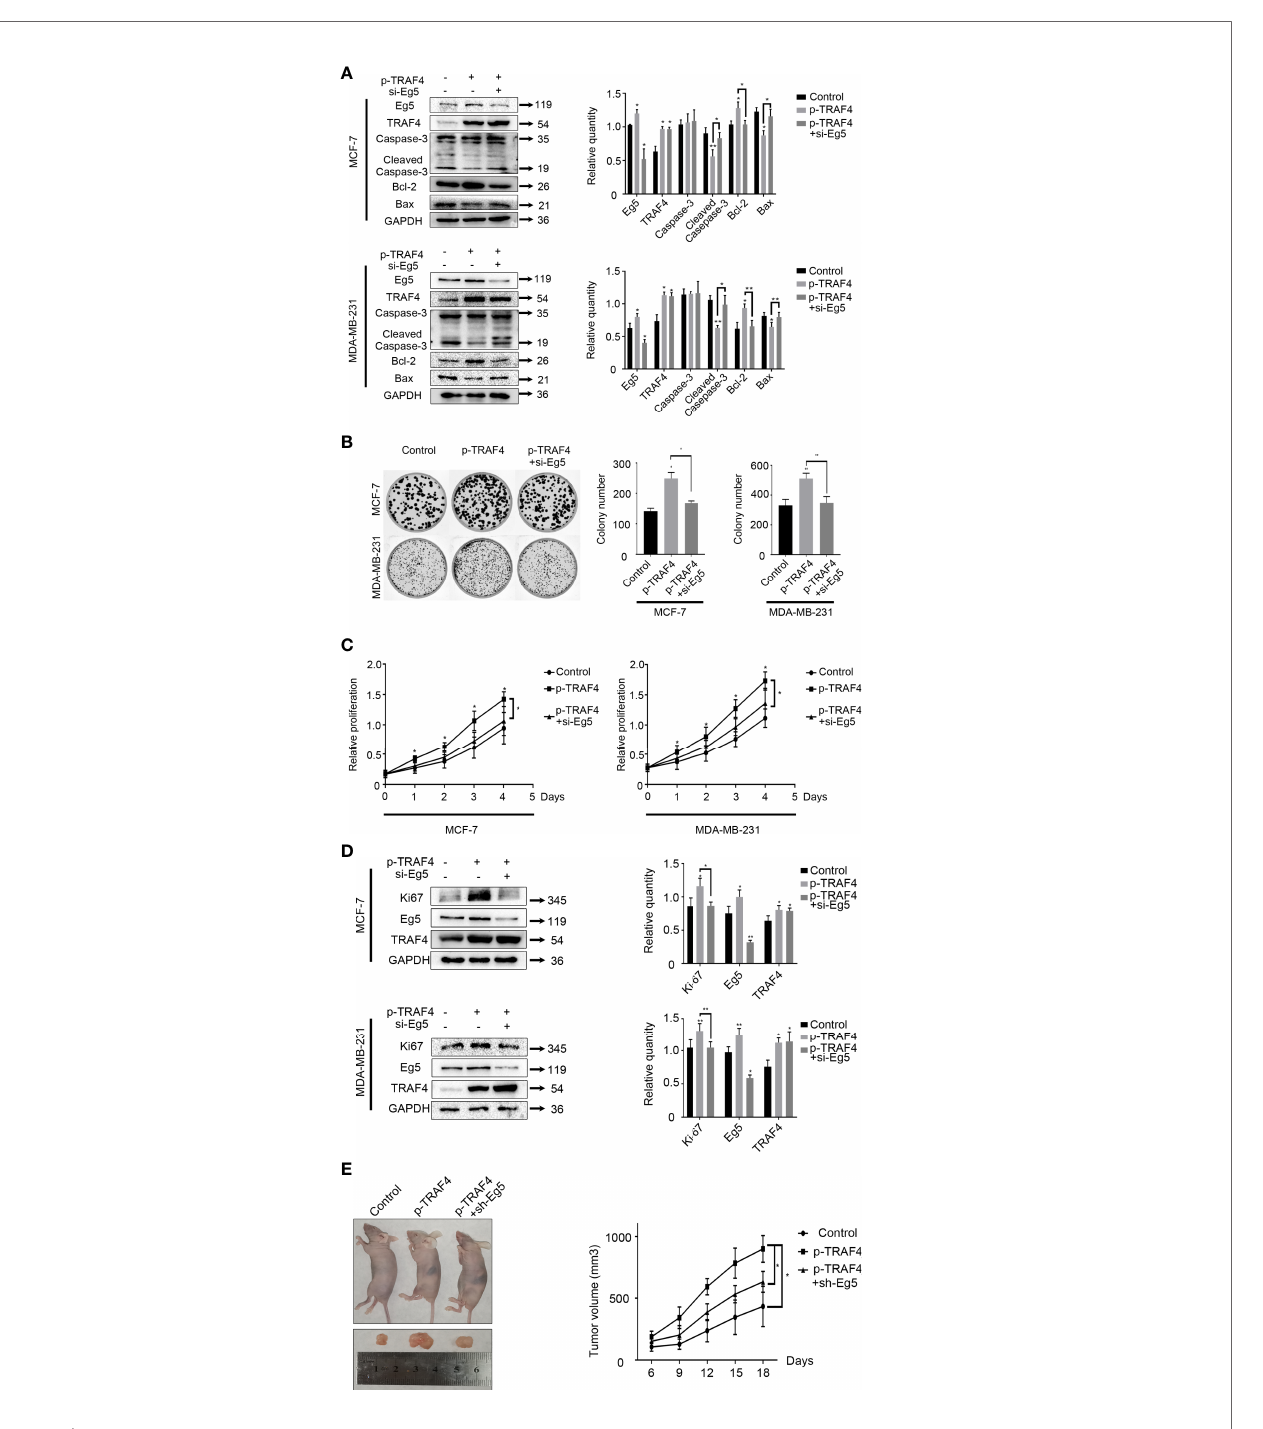
FIGURE 6 | TRAF4 inhibits the apoptosis and promotes the proliferation of breast cancer cells. (A) TRAF4 inhibits the apoptosis of breast cancer cells. MCF-7 cells and MDA-MB-231 cells were transfected with TRAF4 si-RNA or co-transfected with TRAF4 si-RNA and Eg5 over-protein level plasmid. Western blot assays were used to demonstrate the protein level of apoptosis-related protein. GAPDH was used as an internal control. Data represent mean ± SD ( n = 3). (* p < 0.05, **p<0.01). (B) TRAF4 promotes the proliferation of breast cancer cells. MCF-7 cells and MDA-MB-231 cells were transfected as indicated. Representative images and quanti fi cation of colony formation assays. Data represent mean ± SD ( n = 3). (* p < 0.05, **p<0.01). (C) MCF-7 cells and MDA-MB-231 cells were co-transfected as indicated. An MTT assay was performed to assessproliferation activity in MCF-7 cells and MDA-MB-231 cells. Data represent mean ± SD ( n = 3). (* p < 0.05). (D) MCF-7 cells and MDA-MB-231 cells were transfected as indicated. Western blot assays were used to demonstrate the protein level of Ki-67, Eg5 and TRAF4. GAPDH was used as an internal control. Data represent mean ± SD ( n = 3). (* p < 0.05, **p<0.01). (E) MCF-7 cells transfected as indicated were transplanted into female athymic nude mice. Tumors size was measured every three days. Data represent mean ± SD ( n = 4). (* p <